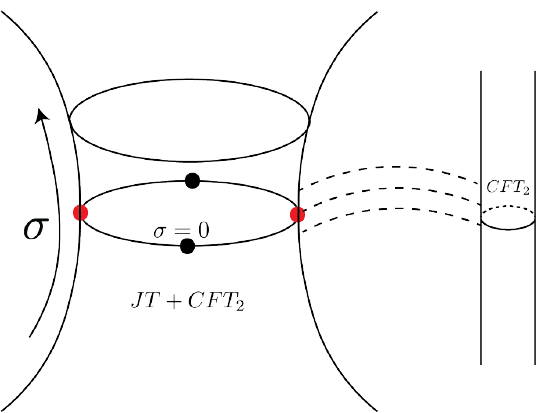
Figure 17. Here we illustrate the Lorentzian interpretations of the Euclidean saddles shown in figure 16. The idea is that for finite τ 0 these saddles describe a situation where a closed dS 2 universe with multiple inflating and crunching regions is encoded in a CFT 2 on a spatial circle. The dashed lines signify the thermal entanglement between the closed universe and the